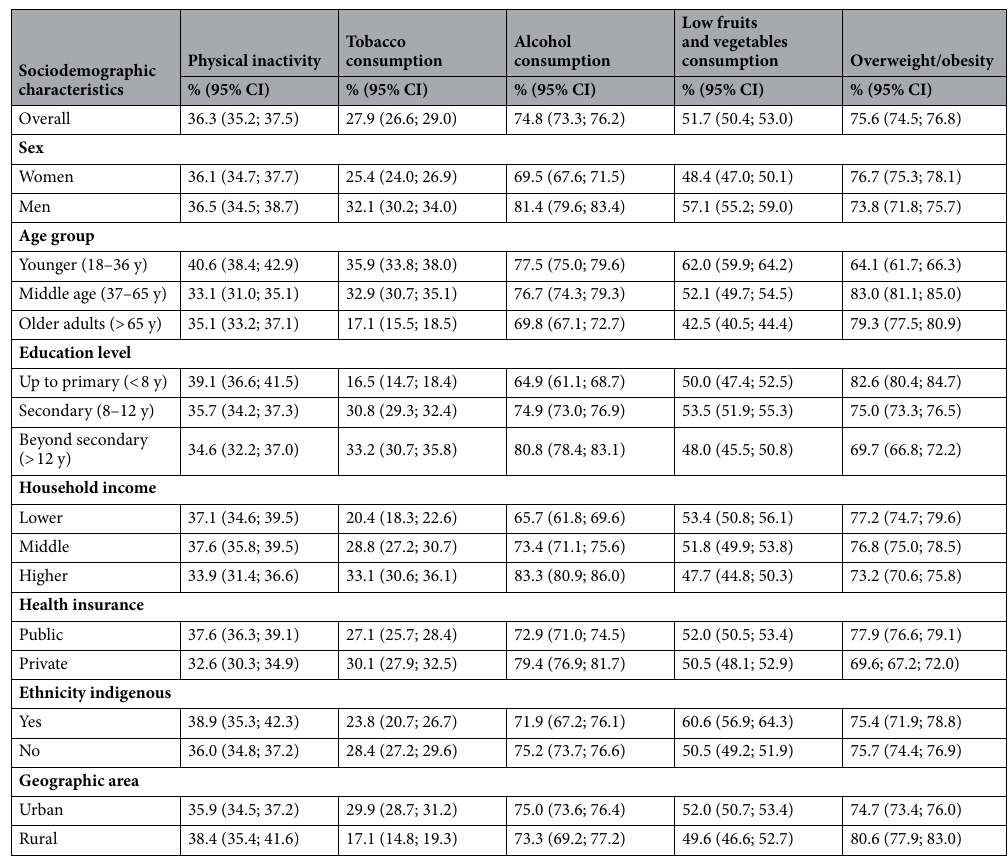
Table 1. Prevalence and 95% confidence intervals of risk factors for non-communicable disease in Chilean residents. 95% CI confidence interval 95%, y